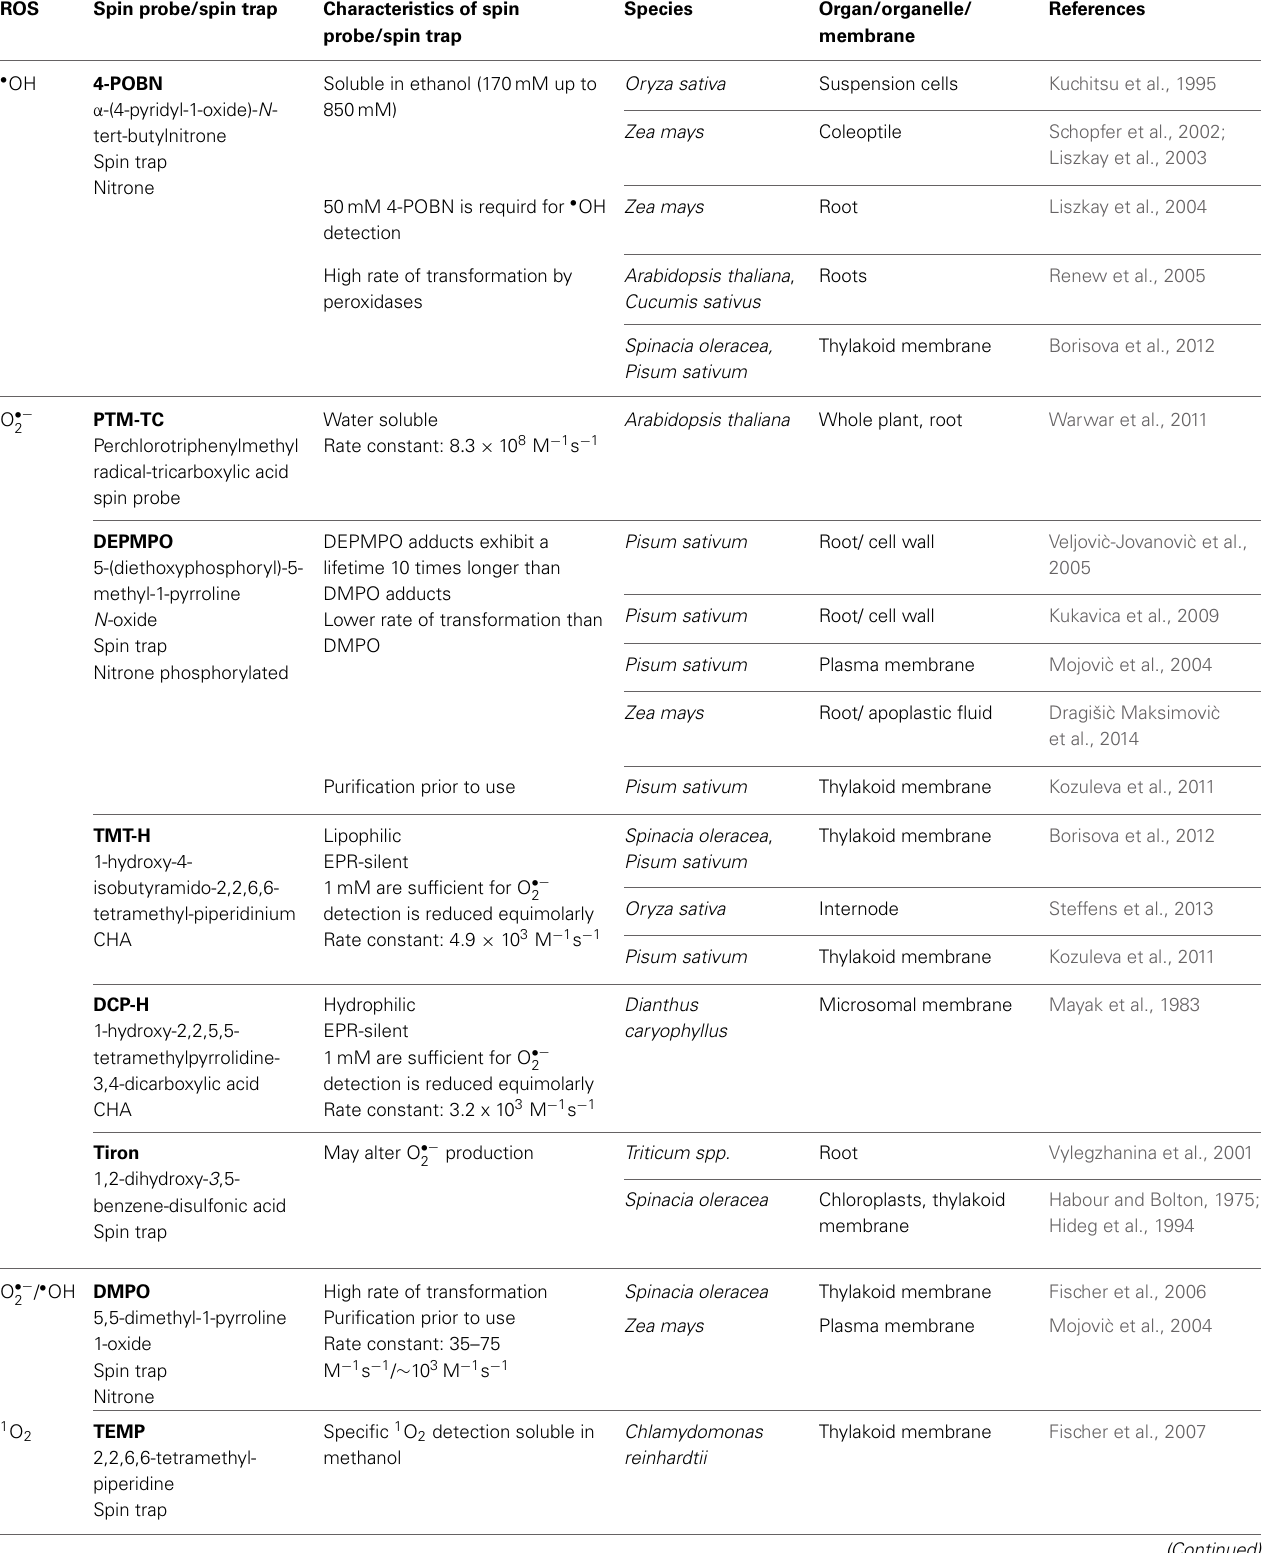
, and 1 O 2 in planta.